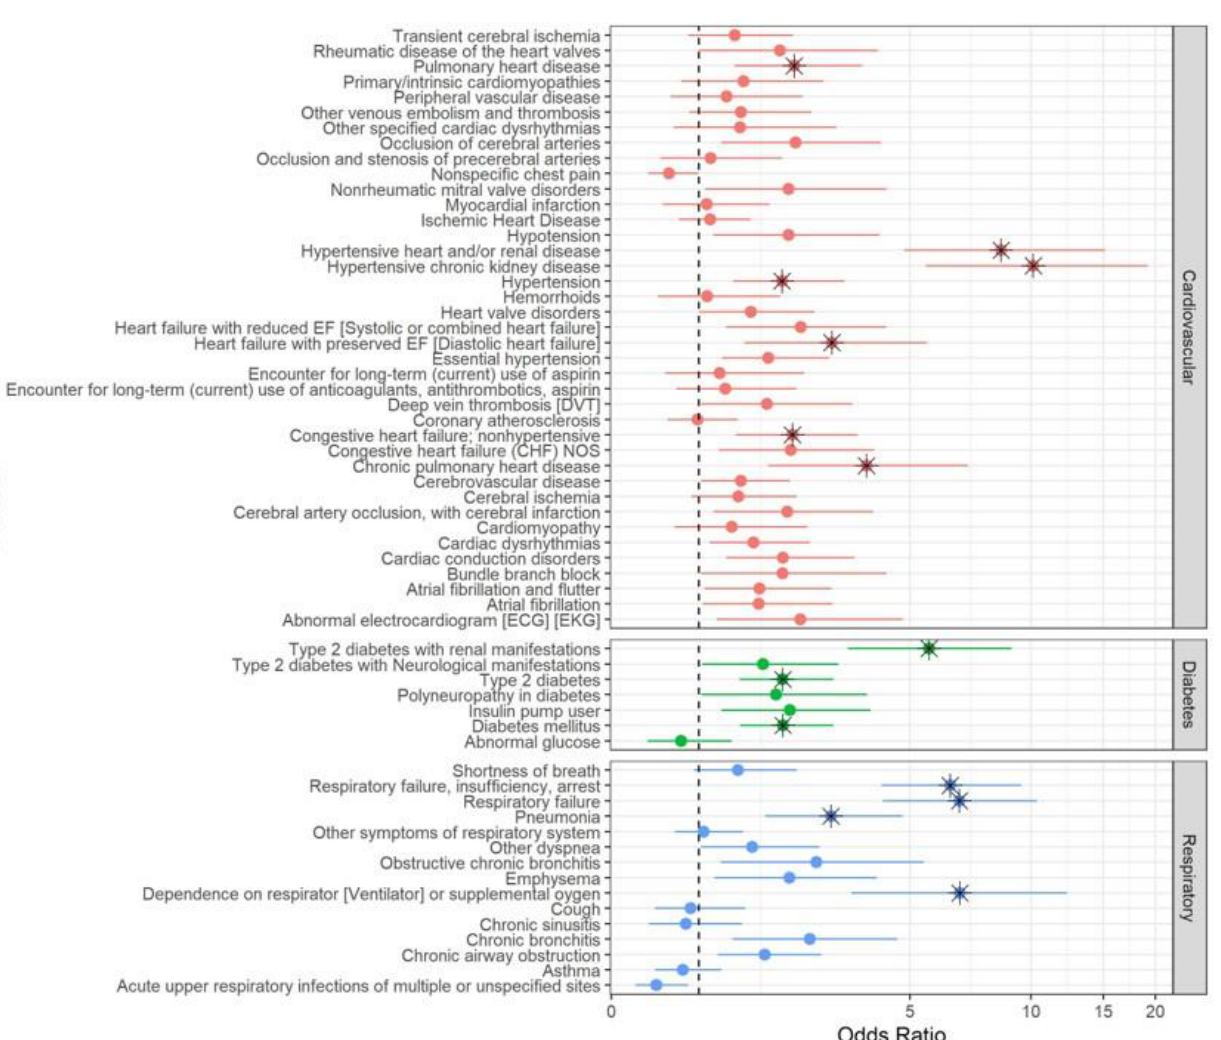
Figure 2. Select Phecodes. Adjusted odds ratios and 95% confidence intervals for risk from death from COVID-19 for selected phecodes. Phecodes with significant odds ratios after Bonferroni correction ( p < 0.0008) are labeled with an asterisk.